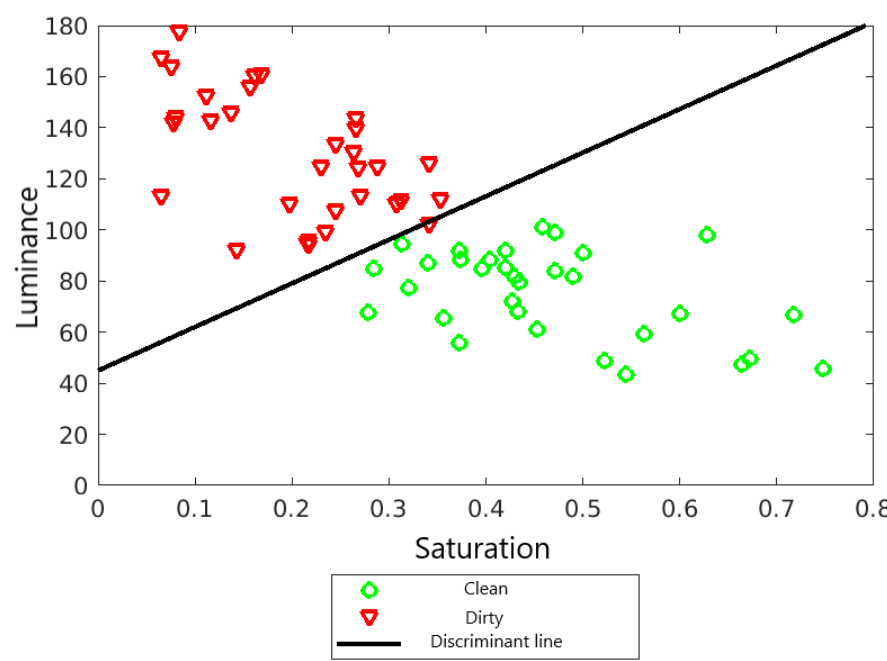
Figure 10. Decision boundary between classes.